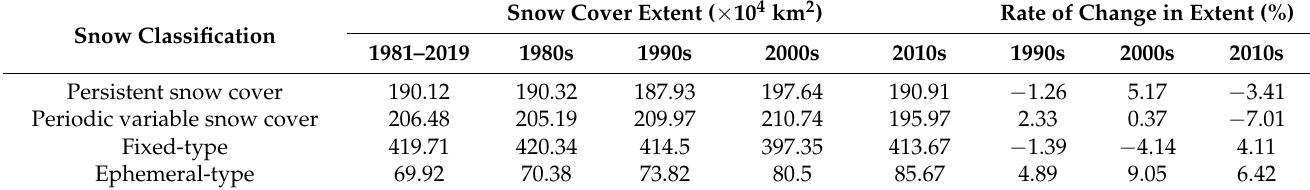
Table 1. Extents of snow cover classification and their interdecadal relative change rates.